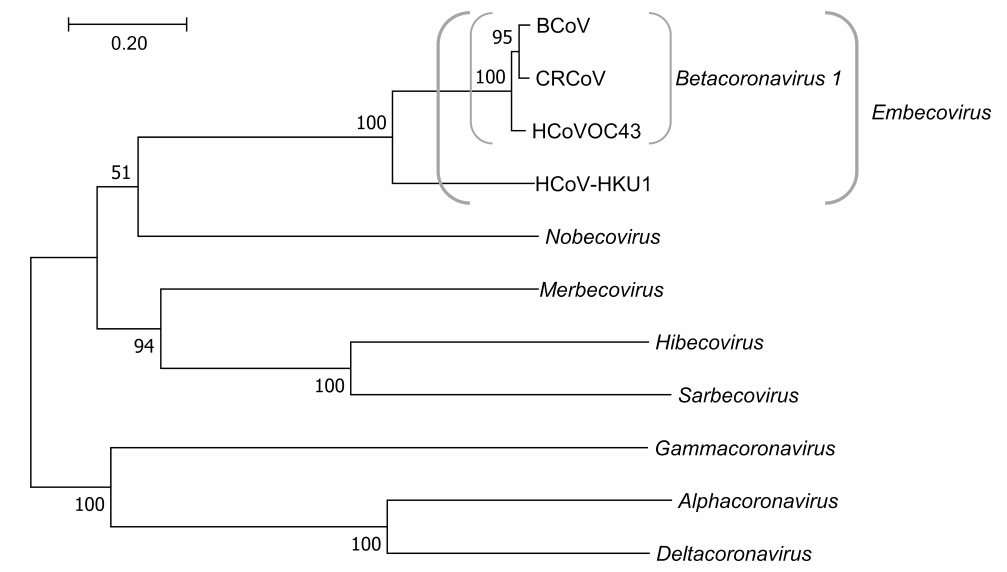
Figure 1. Phylogenetic tree of Orthocoronavirinae . The evolutionary history was inferred based on the sequences of the complete spike gene by using the Maximum Likelihood method based on General Time Reversible model [7]. The tree with the highest log likelihood-33860.47) is shown. The percentage of trees in which the associated taxa clustered together is shown next to the branches. Initial tree(s) for the heuristic search were obtained automatically by applying Neighbor-Join and BioNJ algorithms to a matrix of pairwise distances estimated using the Maximum Composite Likelihood (MCL) approach, and then selecting the topology with superior log likelihood value. Discrete Gamma distribution was used to model evolutionary rate differences among sites (5 categories (+G, parameter = 3.0783)). The rate variation model allowed for some sites to be evolutionarily invariable ([+I], 5.04% sites). The tree is drawn to scale, with branch lengths measured in the number of substitutions per site. The analysis involved 11 nucleotide sequences. All positions containing gaps and missing data were eliminated. There was a total of 3117 positions in the final dataset. Evolutionary analyses were conducted in MEGA7 [8]. Alphacoronavirus : Human coronavirus 229E (HCoV-229E; NC_002645); Deltacoronavirus : Wigeon coronavirus HKU20 (NC_016995); Gammacoronavirus : Beluga Whale coronavirus